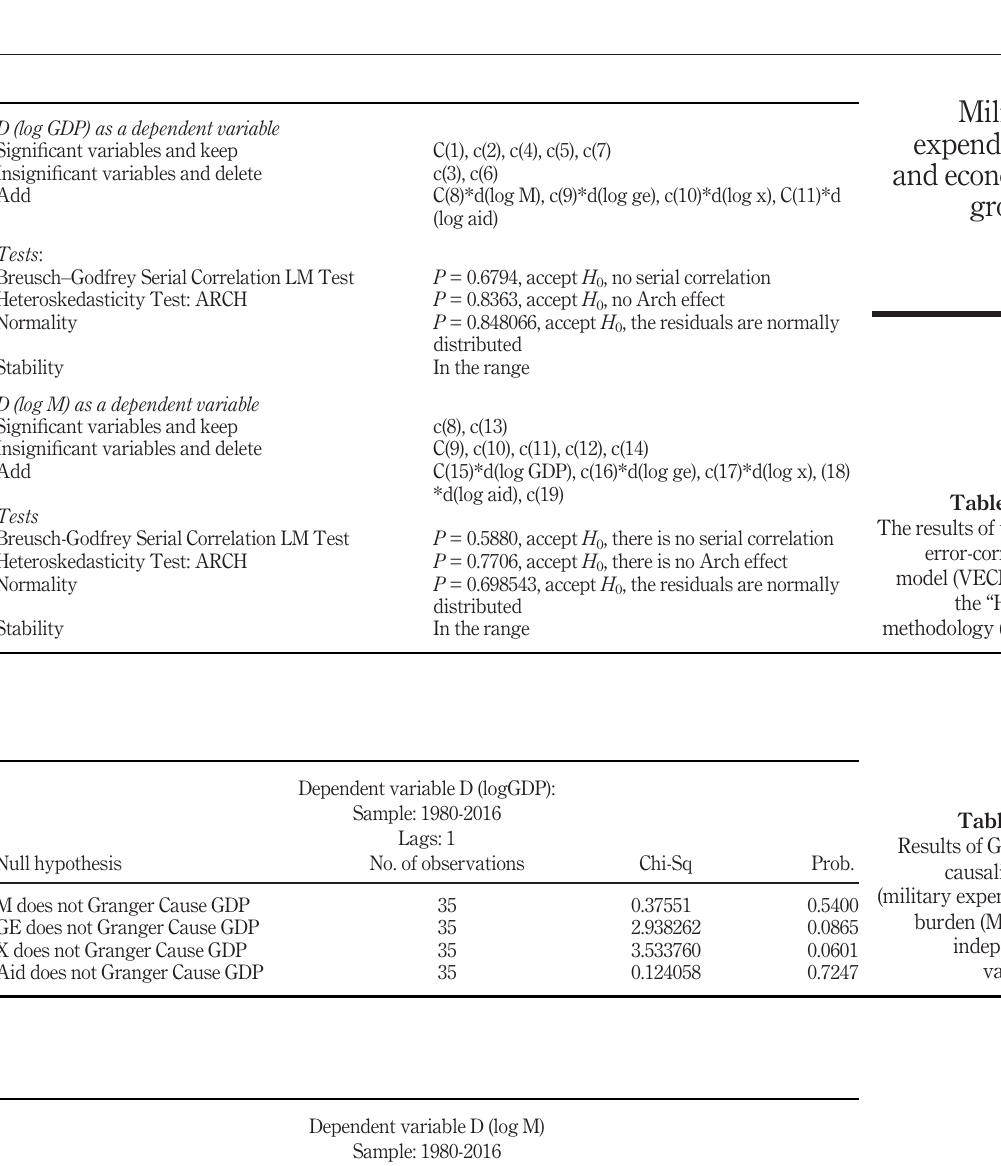
Table AVI. Results of